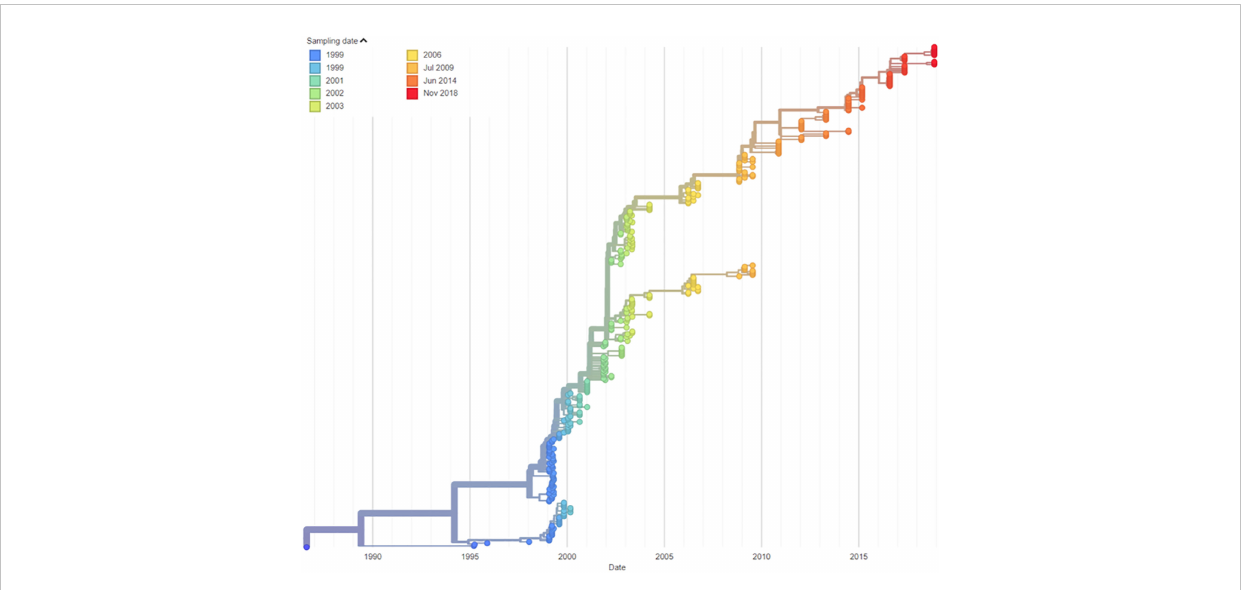
FIGURE 1 Patient iVDPV sequence evolution and molecular clock analysis.